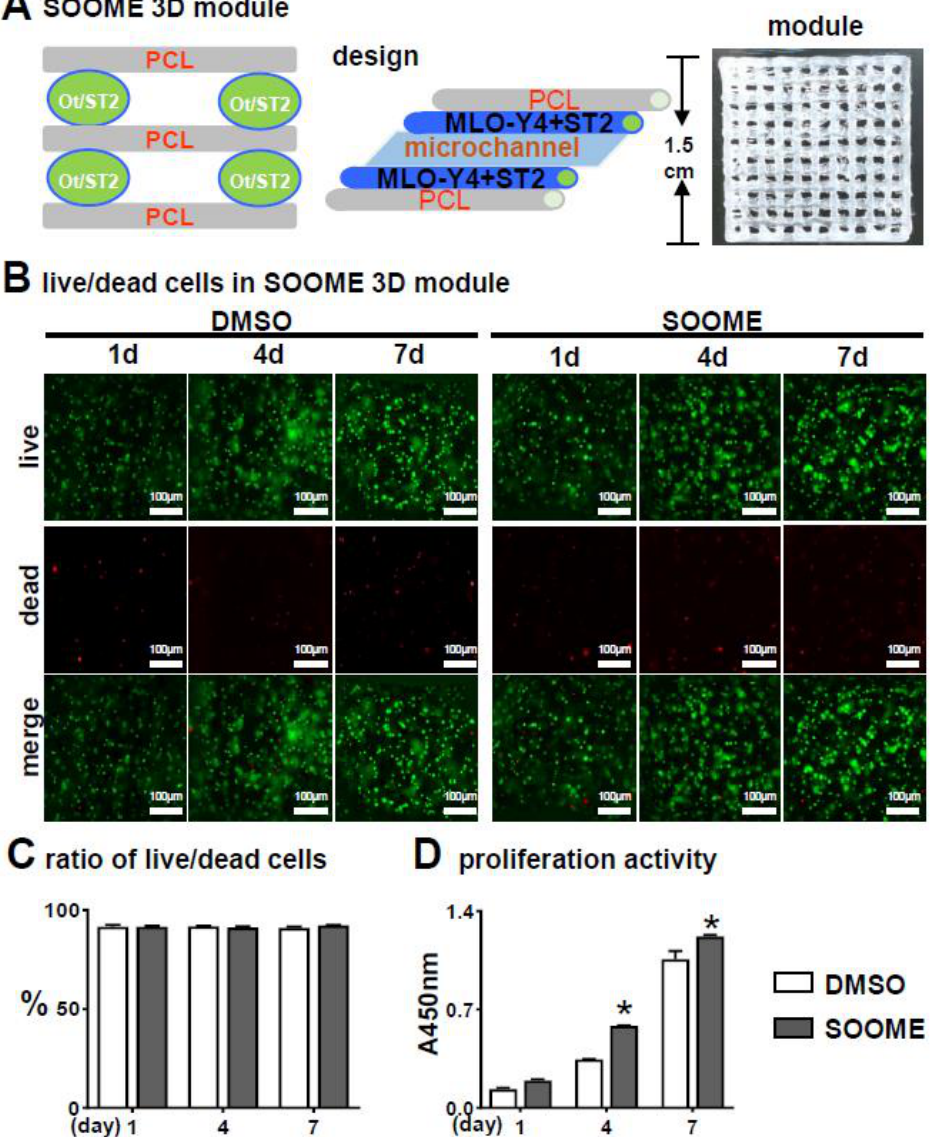
Figure 4. Effects of the SOOME in PCI3D modules on cell survival and growth. ( A ) A schematic PCI3D system design and its printed module image (right) reciprocally printed with PCL beams and cell-laden hydrogel beams. ( B ) Live/dead cell assay to detect the cells’ survival and proliferation at predetermined time points (1, 4 and 7 days after in vitro culture). Cells displayed calcein-AM positive (green) for live cells or EthD-1 negative (red) for dead cells. Scale bar = 100 µm. ( C ) The rate of live/dead cells and ( D ) proliferation activity was analyzed by imaging and CCK8 assay kit. The * symbol indicates p < 0.05 versus DMSO control by Two-way ANOVA; n = 3.